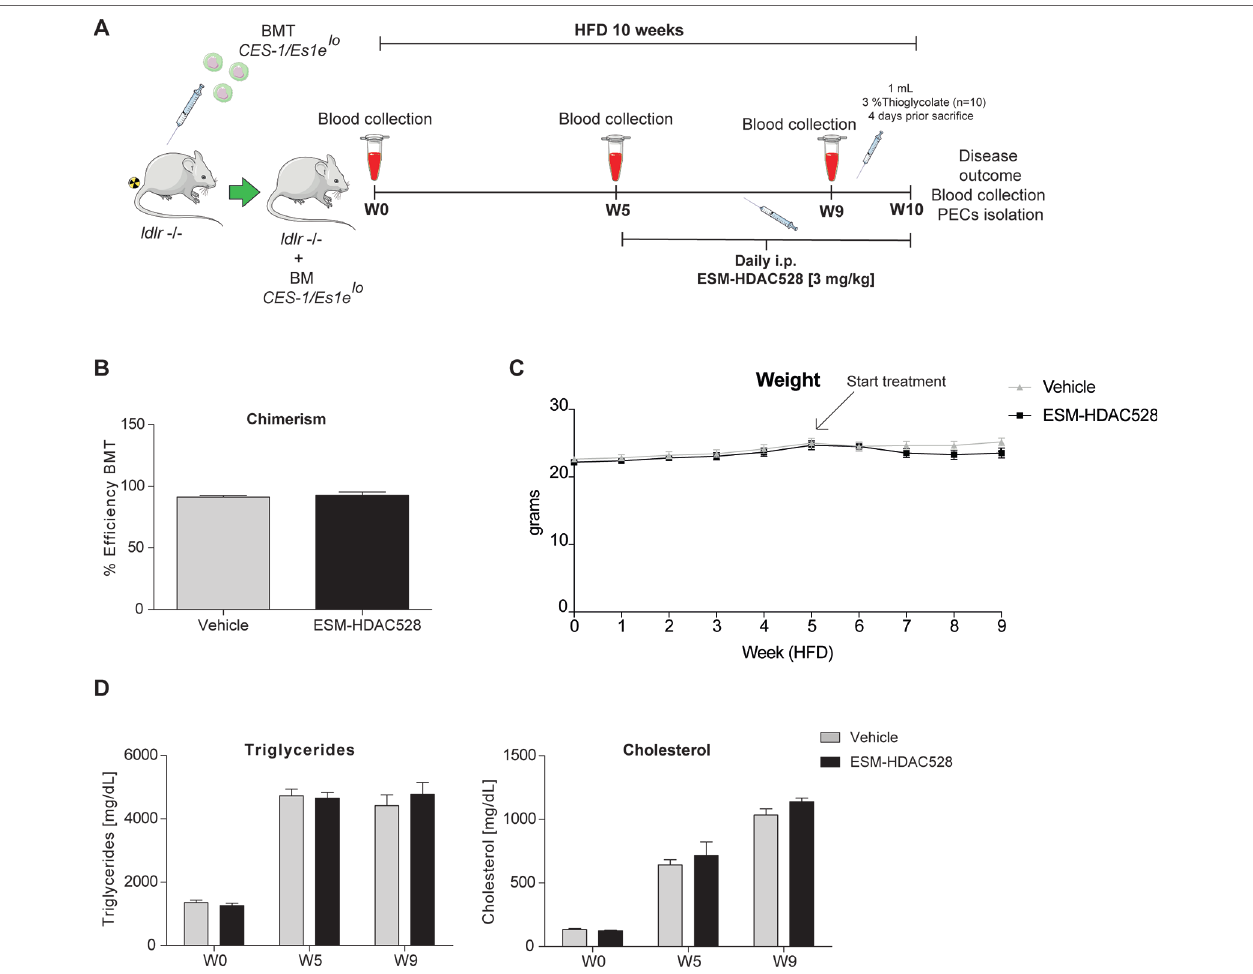
FIGURE 3 | ESM-HDAC528 treatment does not affect clinical features in a model of atherosclerosis. (A) Design of the atherosclerosis study. The ldlr knockout mice were transplanted with bone marrow from CES-1/Es1e lo mice. The mice were divided into two groups ESM-HDAC528 (n = 19) and vehicle (n = 19). Mice were on an HFD for 10 weeks. On week 5, the mice were treated with 3 mg/kg ESM-HDAC528 or vehicle by daily i.p. injection. Blood was collected on week 0, 5, 9, and 10. On week 10, mice were sacrificed, the disease outcome was assessed and PECs were isolated. (B) Efficiency of the BMT in both groups. n = 19 vehicle vs. n = 18 ESM- HDAC528. (C) Weight of the mice from both groups during the study. n = 19 vehicle vs. n = 18 ESM-HDAC528 (D) Triglycerides and cholesterol levels of the groups on week 0, 5, and 9. n = 19 vehicle vs. n = 18 ESM-HDAC528. Statistical significance was determined by unpaired t -test (B) or two-way ANOVA with Bonferroni correction (C and D) (p < 0.05). All error bars represent the